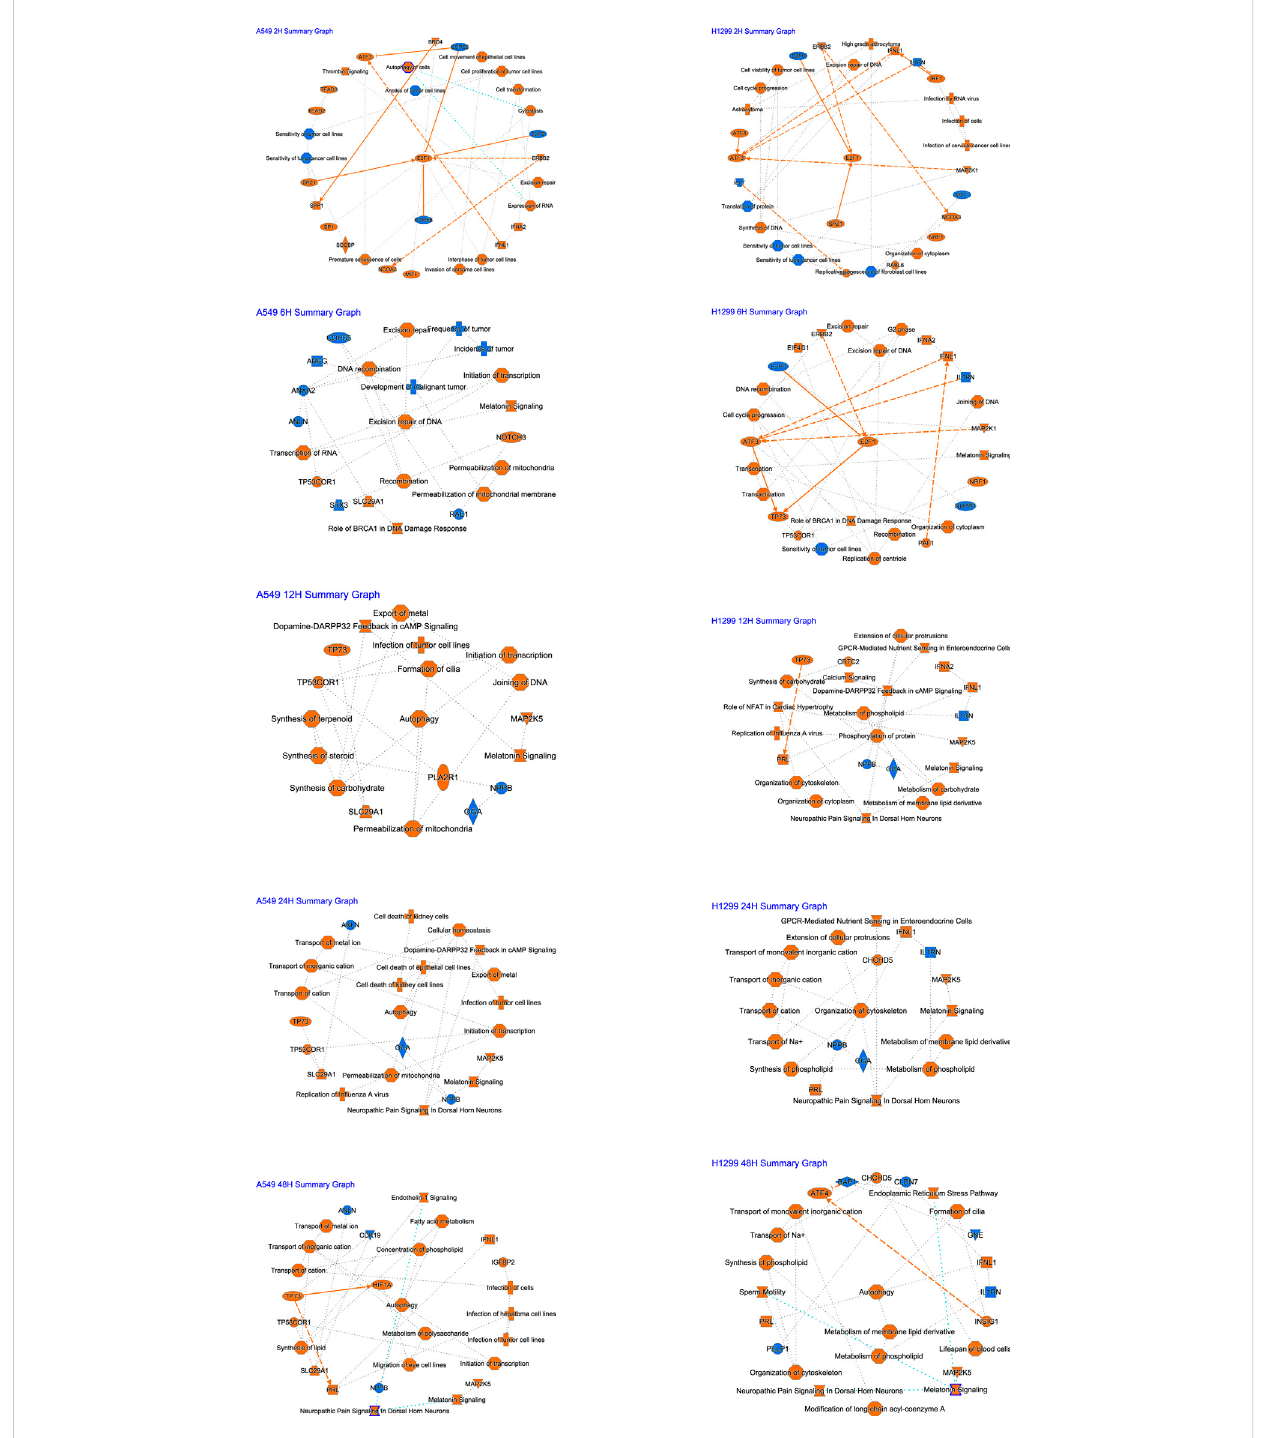
FIGURE 3 Summary of IPA functions for radiotherapy of A549 and H1299 cells at fi ve time points (2, 6, 12, 24, and 48